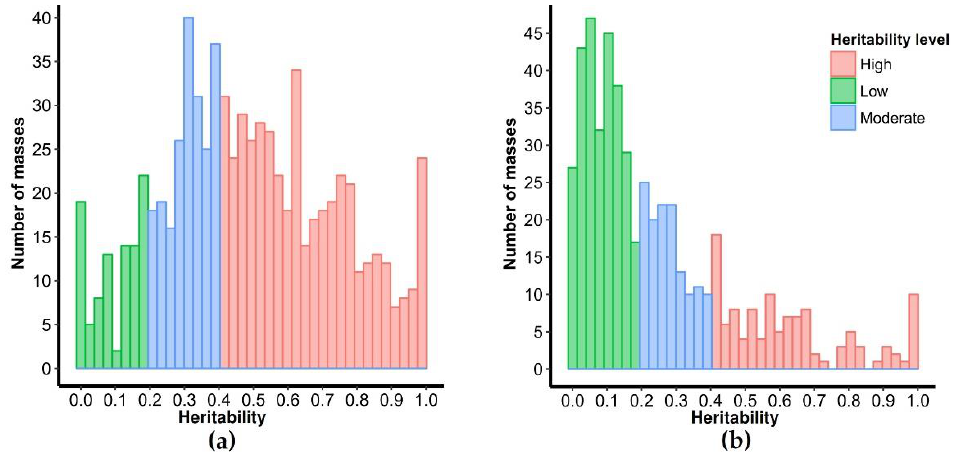
Figure 2. Frequency distribution of heritability of mass peaks detected in fruits ( a ) and leaves ( b ). The histograms demonstrate the distribution of the heritability level. Colors depict values according to low, moderate and high heritability levels.